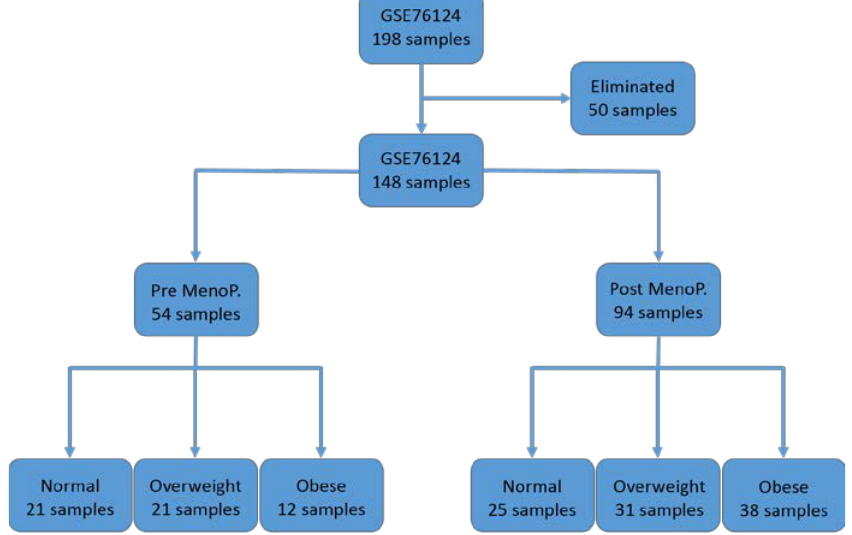
Figure 1. Distribution of the samples used in the analysis by menopausal status and body mass index (BMI). Note: 50 individual patients with missing information on menopausal status and BMI were excluded from the analysis.